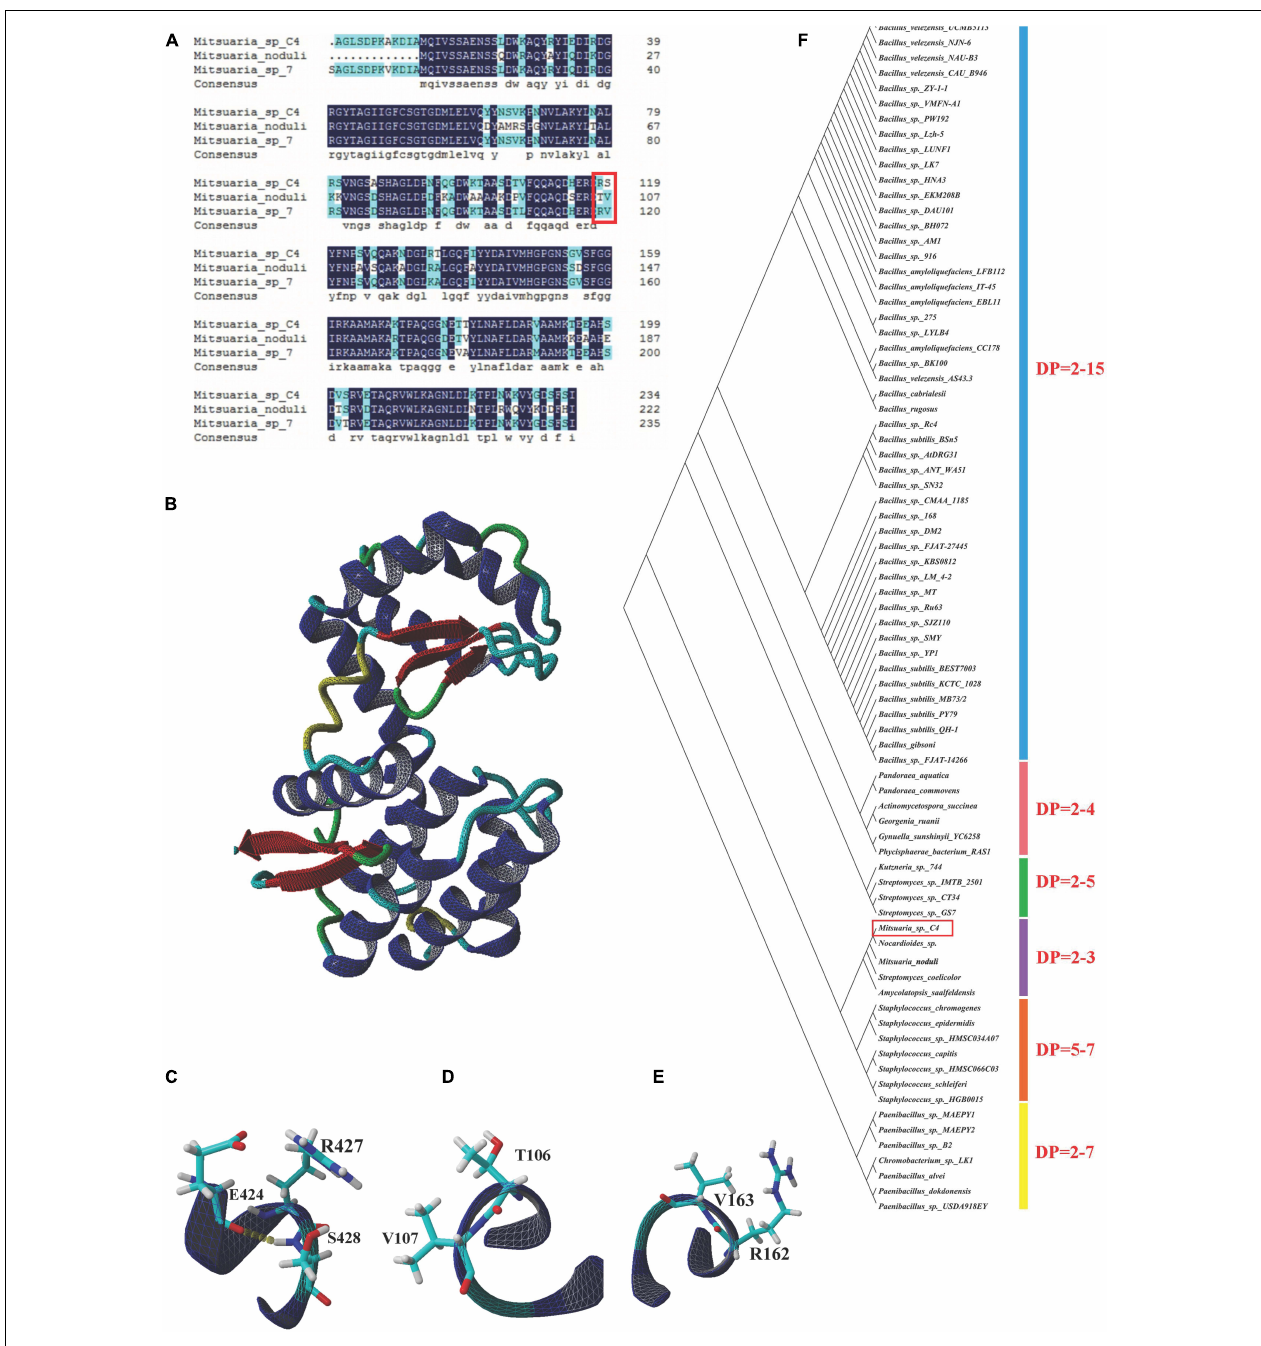
FIGURE 6 | Bioinformatic analysis of COSE. (A) Multiple amino acid sequence alignment of COSE belonging to family GHs-46 in Mitsuaria sp. C4, Mitsuaria sp. 7, and M. noduli . Typical catalytic sites were emphasized with red square. (B) Three-dimensional structures of COSE in Streptomyces sp. N174. (C) Region of COSE with Arg and Ser sites in Mitsuaria sp. C4. (D) Region of COSE with Arg and Val sites in M. noduli . (E) Region of COSE with Thr and Val sites in Mitsuaria sp. 7. (F) Phylogenetic analysis of GHs-46 family COSEs. Phylogenetic divergence was analyzed using MEGA 7.0